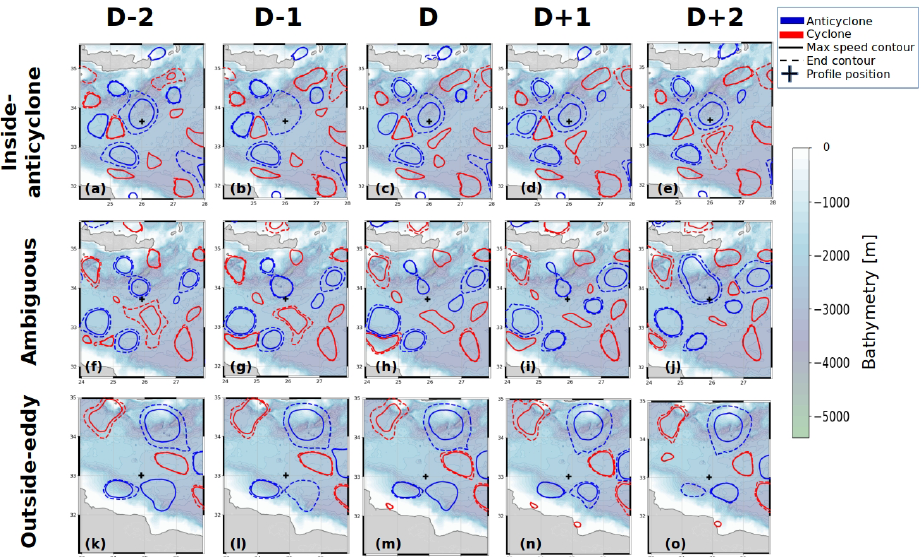
Figure 2. Profile colocalization with eddy contours for an “inside-anticyclone” profile (a–e) , an “ambiguous” profile (f–j) and an “outside- eddy” profile (k–o) . Profile cast position is assumed to be fixed and is compared to eddy contours at D − 2, D − 1, D , D + 1 and D + 2, D being the profile cast